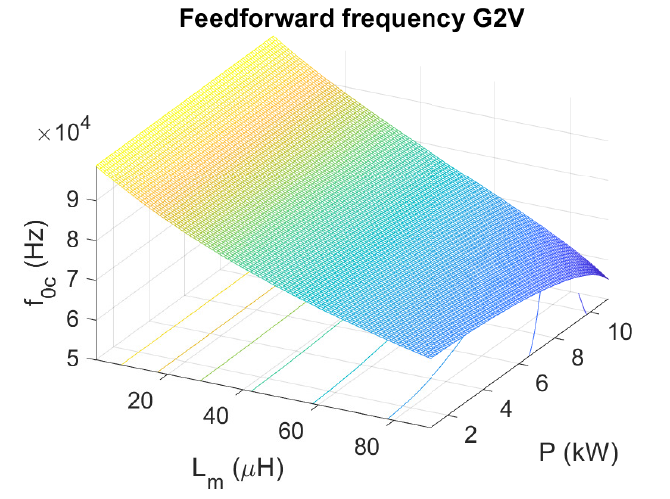
Figure 9. G2V feedforward frequency in function of L m .